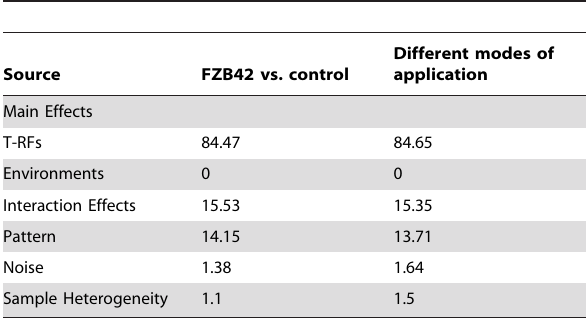
Table 4. Percent variation in the bacterial community T-RFLP data revealed by online software T